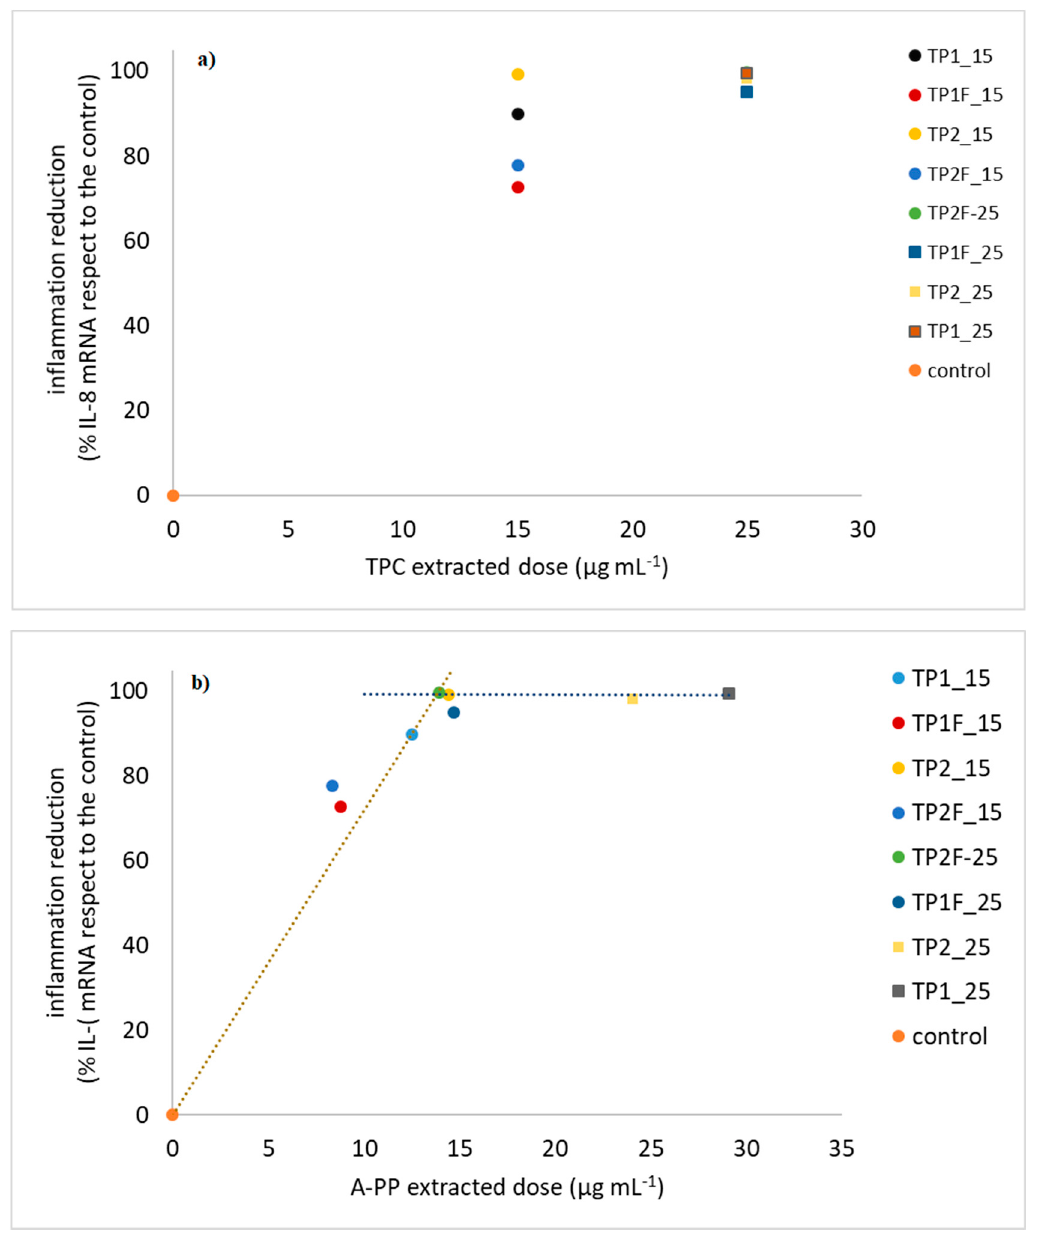
Figure 1. Relationships among inflammation reduction and TP extract dose expressed as total polyphenol content ( a ) and A-PP extracted ( b ).